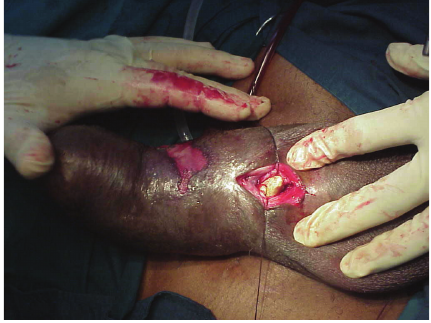
Figure 3: Necrotic area of penis opened and debrided.